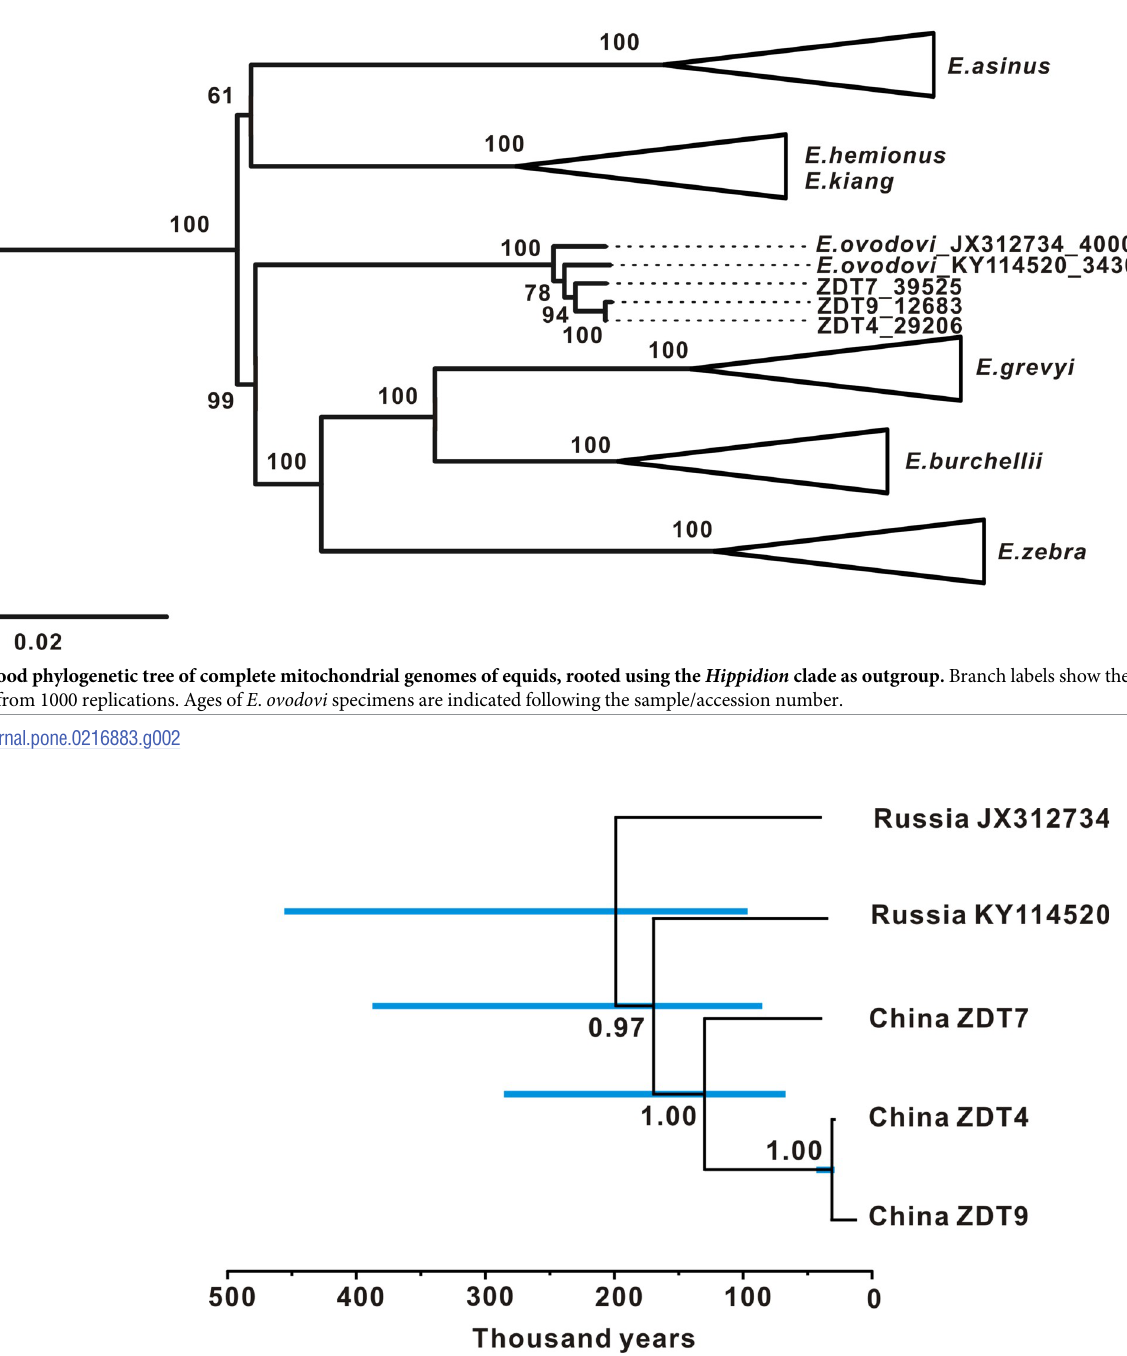
Fig 3. Maximum clade credibility tree of E . ovodovi haplotypes. Nodes heights are centred on the median posterior age estimate (x-axis) and tips on sample ages. Blue node bars show 95% credibility intervals of the coalescence times. Branch labels show posterior clade